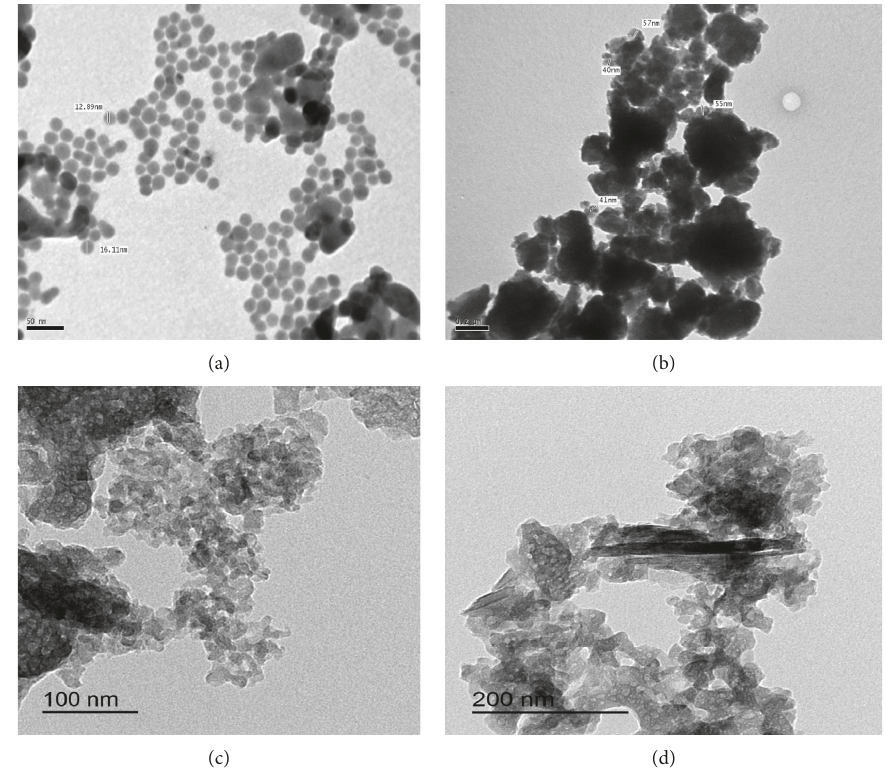
Figure 5: TEM images of (a) NS; (b) GNPs; (c) the NSG nanocomposite (100nm); and (d) the NSG nanocomposite (200